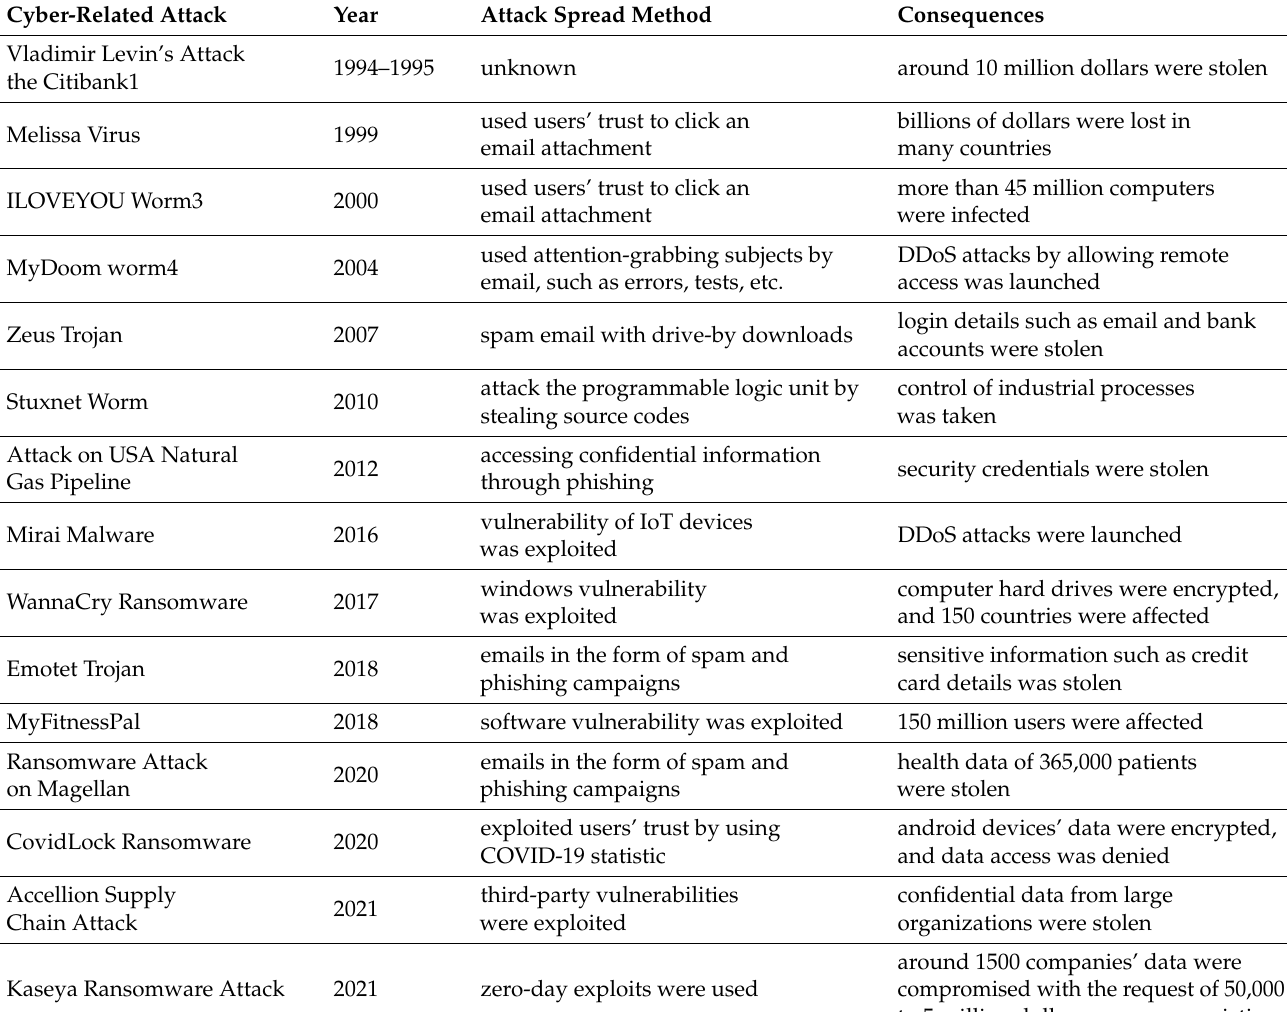
Table 3. The evolution of cyber attacks over the years